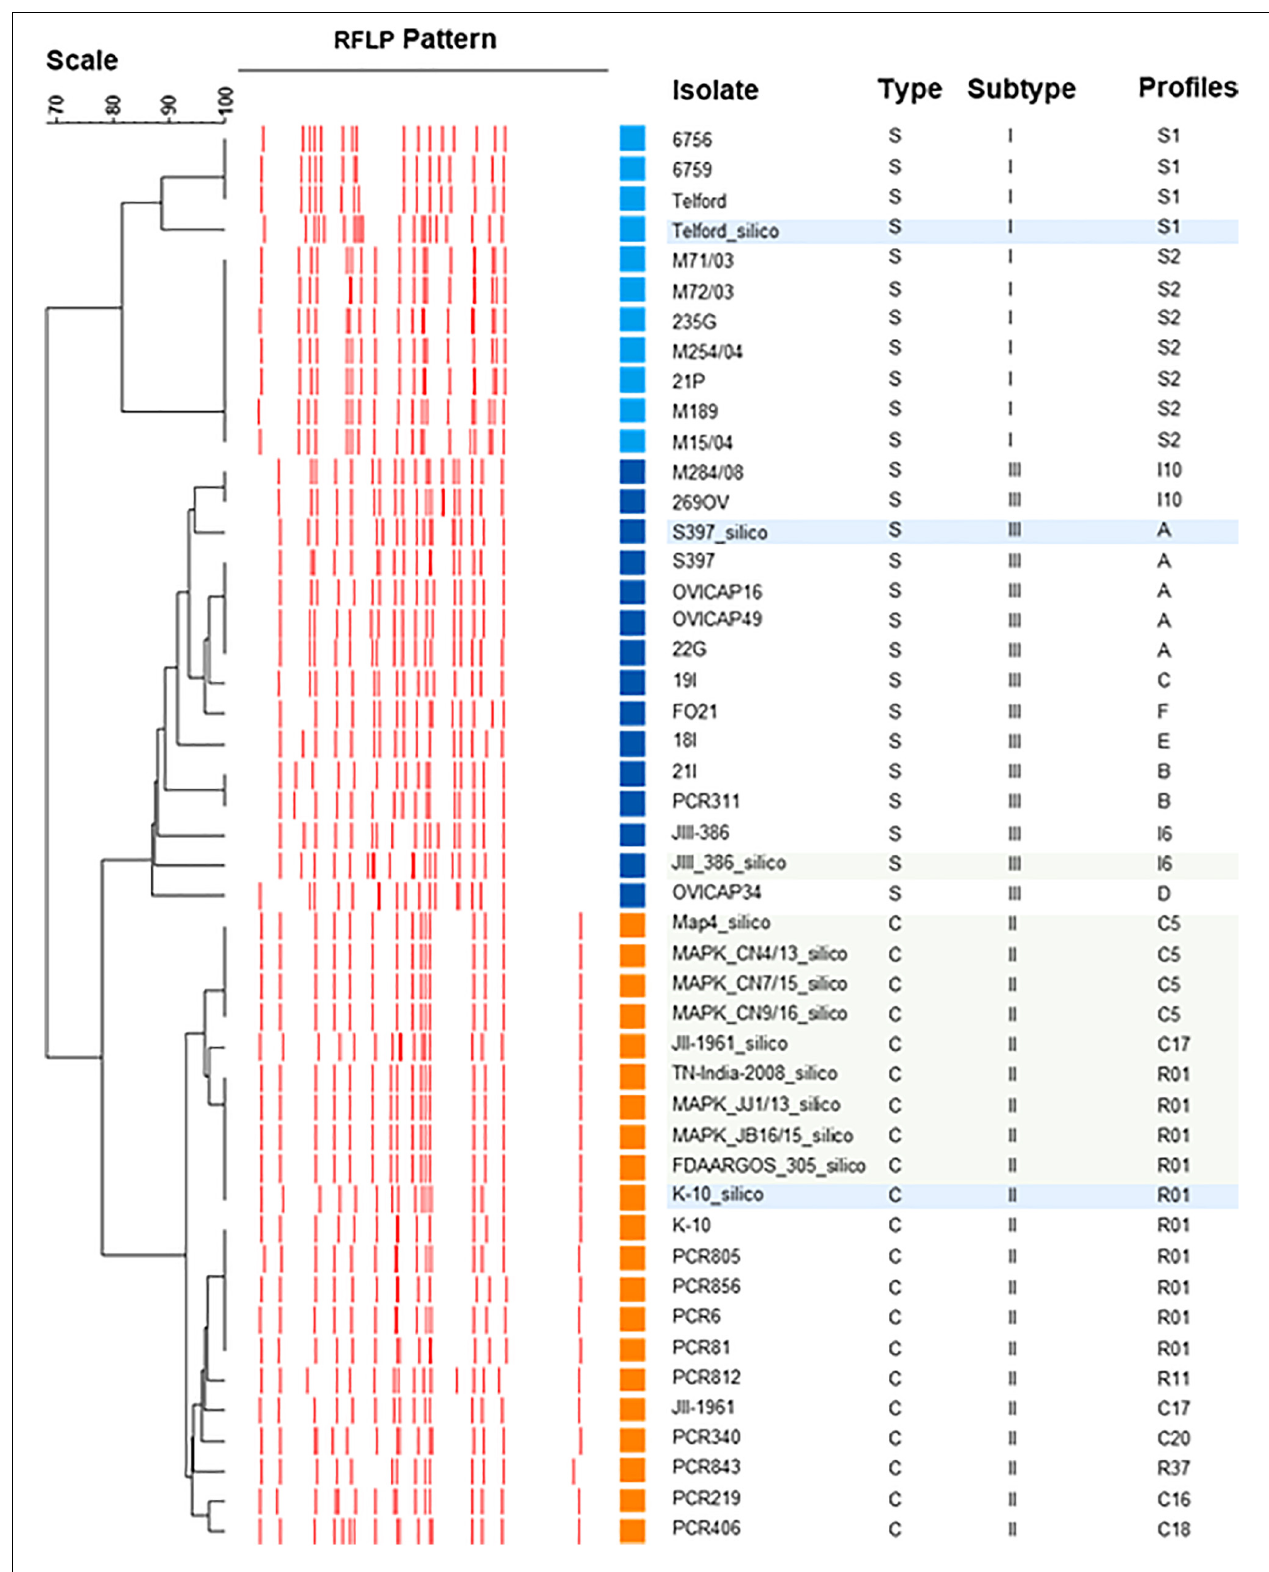
FIGURE 4 | IS 900 RFLP Phylogeny. Phylogeny RFLP with profiles established in silico and integrated into the database are indicated by blue boxes for the three reference genomes of C-type and S-type subtypes I and III and in green boxes for the other complete genomes available for Map .